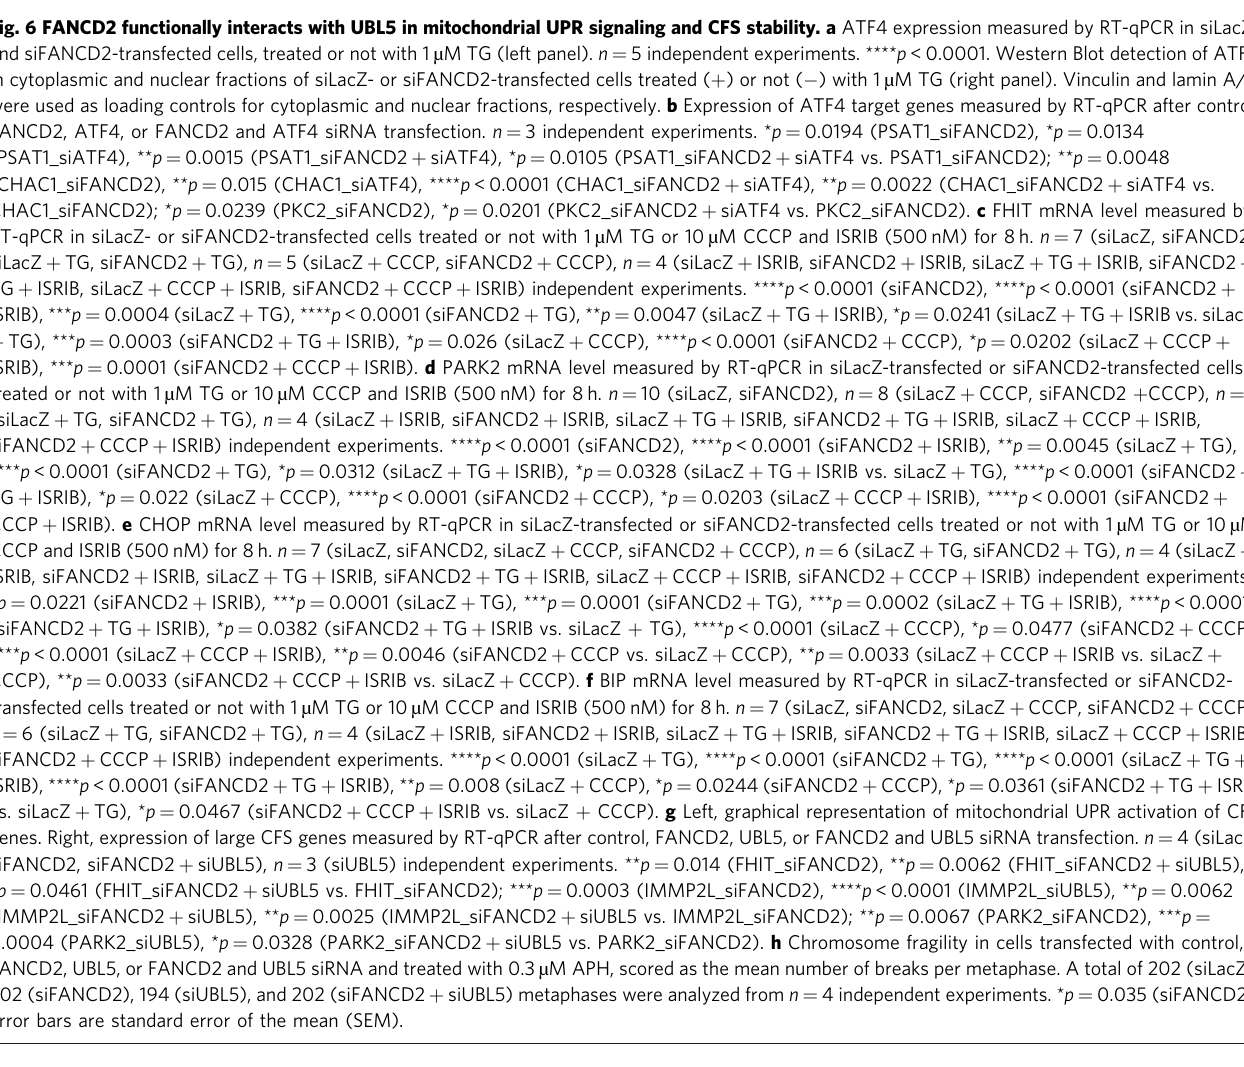
Fig. 6 FANCD2 functionally interacts with UBL5 in mitochondrial UPR signaling and CFS stability. a ATF4 expression measured by RT-qPCR in siLacZ- and siFANCD2-transfected cells, treated or not with 1 µ M TG (left panel). n = 5 independent experiments. **** p < 0.0001. Western Blot detection of ATF4 in cytoplasmic and nuclear fractions of siLacZ- or siFANCD2-transfected cells treated ( + ) or not ( − ) with 1 µ M TG (right panel). Vinculin and lamin A/C were used as loading controls for cytoplasmic and nuclear fractions, respectively. b Expression of ATF4 target genes measured by RT-qPCR after